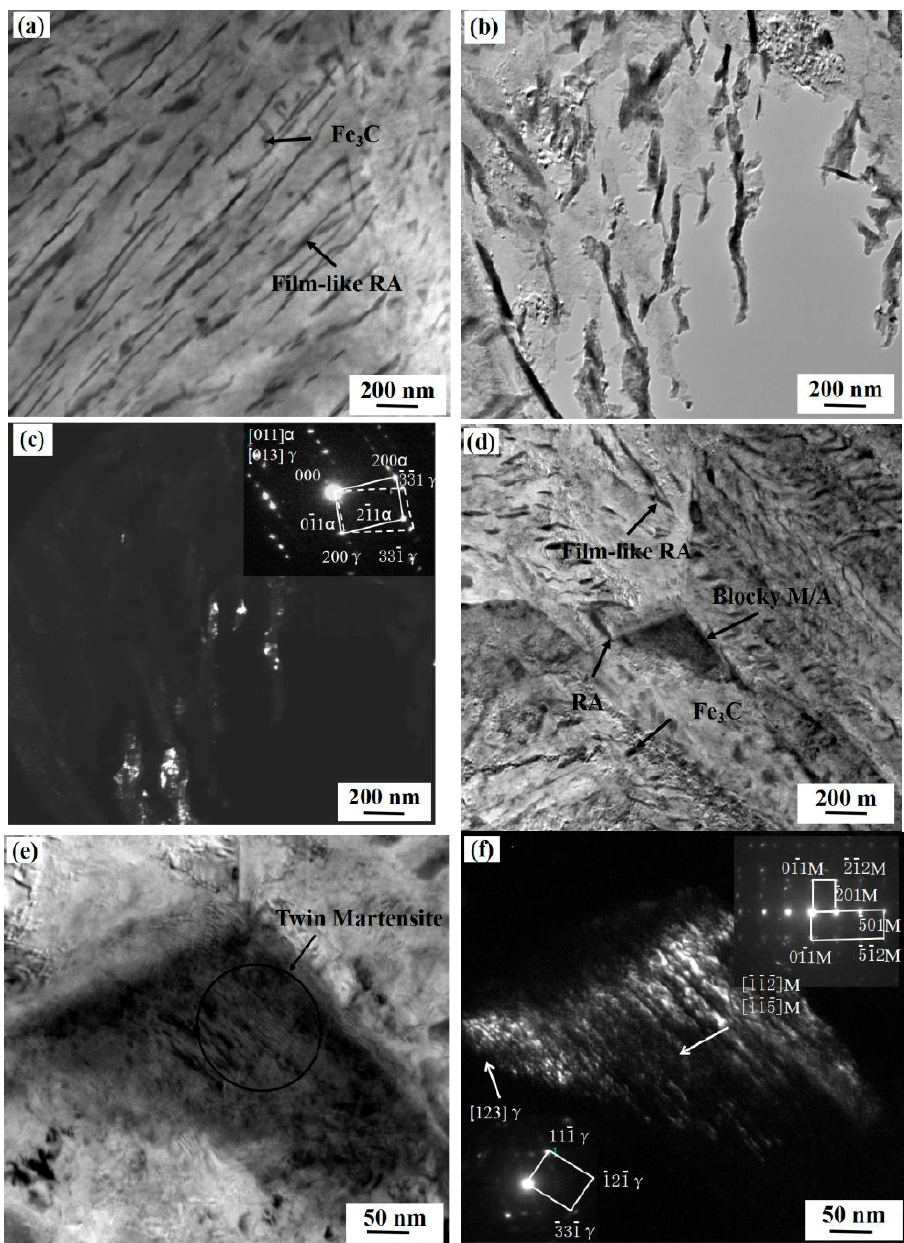
Figure 6. The transmission electron microscope (TEM) micrographs of ( a ) morphology, ( b ) bright field (BF) image and ( c ) dark field (DF) image and inserted selected area electron diffraction (SAED) pattern of the retained austenite of the B3 specimen at a strain rate of 500 s − 1 after the dynamic tensile test; ( d ) morphology, ( e ) BF image and ( f ) DF image and inserted SAED pattern of the retained austenite and the twin martensite of the Q&P specimen at a strain rate of 500 s − 1 after the dynamic tensile test.